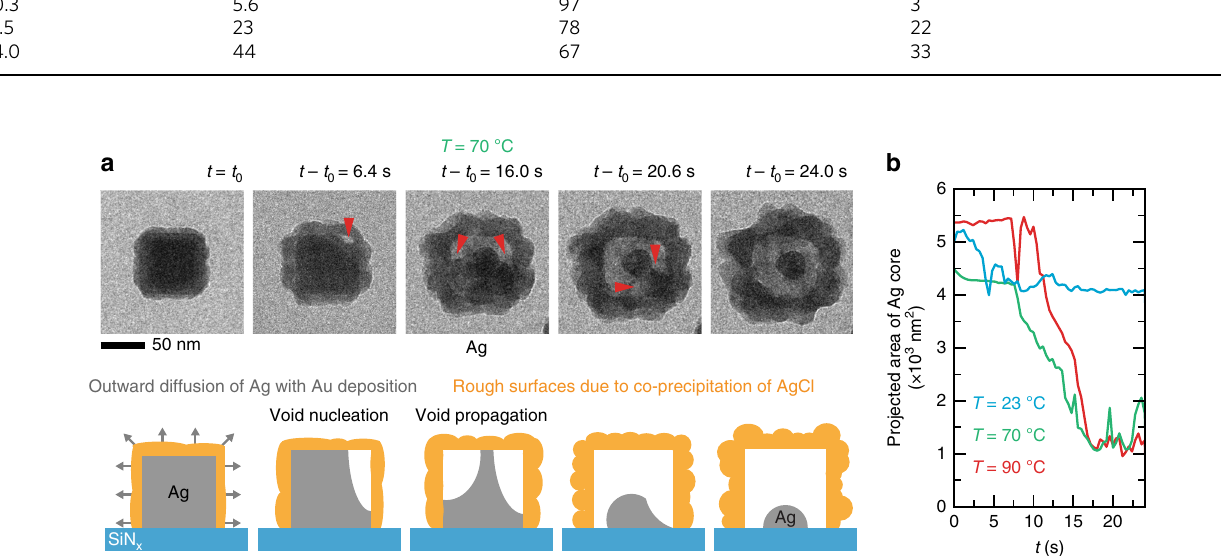
Fig. 3 Galvanic replacement of an Ag nanocube by Au at 70 °C. a Time series of in situ TEM images (Supplementary Movie 3) and corresponding schematic depicting how the morphological evolution can be explained via the propagation of two or more voids. b The projected area of the Ag nanocube cores vs. time at three different